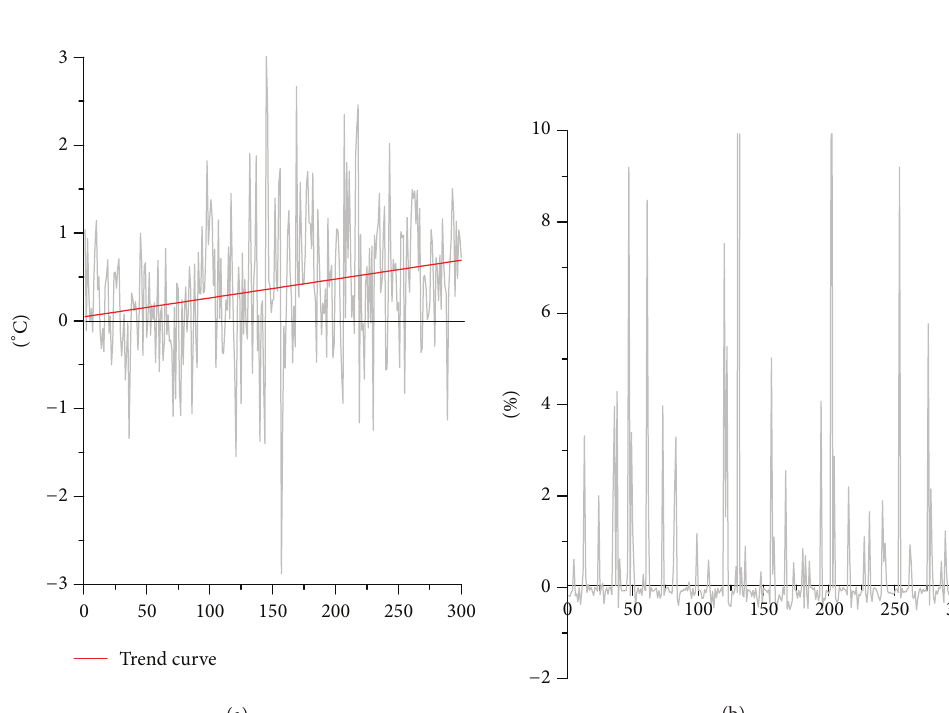
Figure 4: The difference of average monthly temperature and precipitation between 1981–2005 and 2006–2030 in Qilian Weather observed